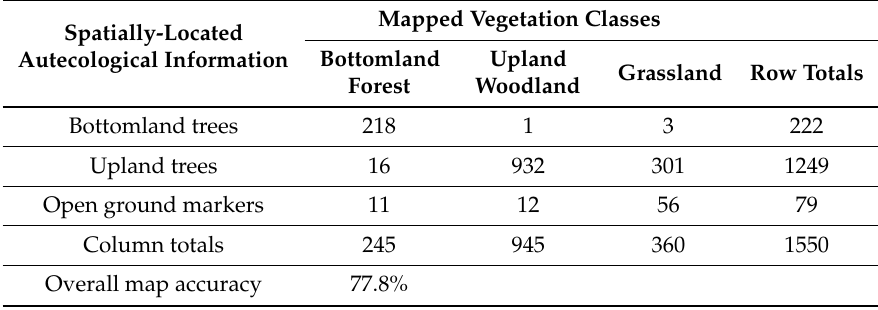
Table 3. Accuracy assessment of tree and open ground marker locations using an errors of commission and omission